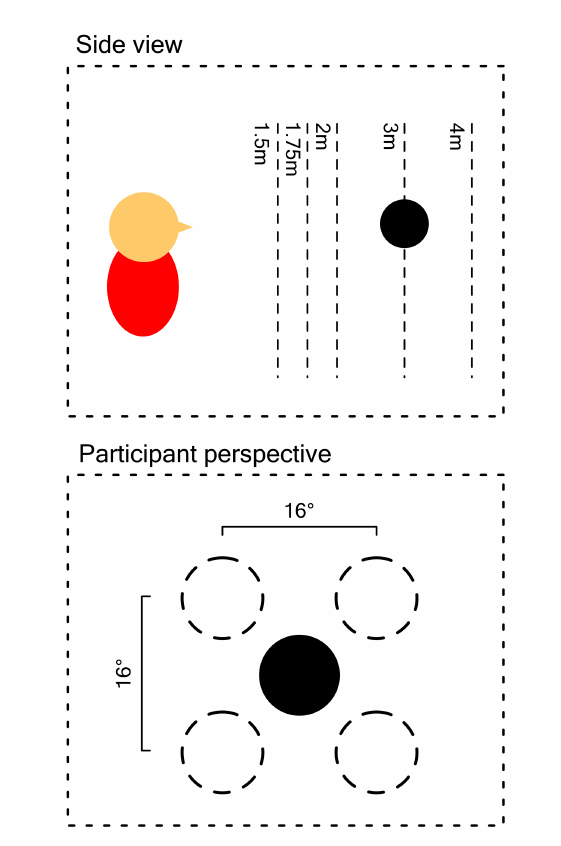
Figure 2. Schematic example of a trial in experiment 2. Dotted lines in the side view show all possible distances. Dotted circles in the participant perspective show alternative target positions at a certain